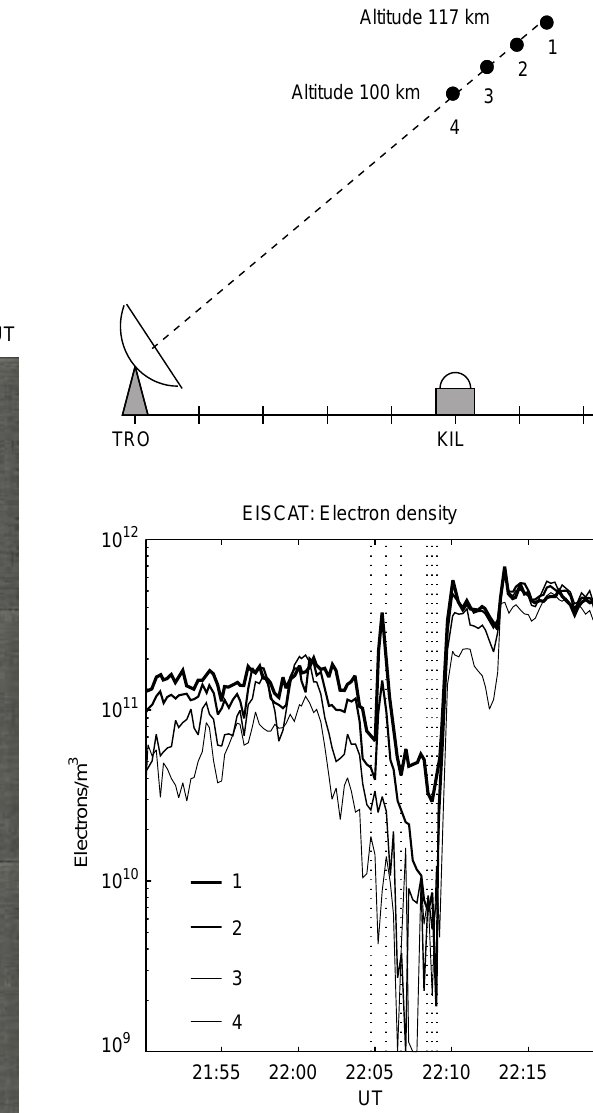
Fig. 7. Fading event on 7 March 1988: ( left ) six ASC frames from KIL, and ( right ) electron density recordings by the EISCAT radar at TRO. In the upper right panel the locations of the measuring points are marked with the same numbers as used for labelling the curves in the